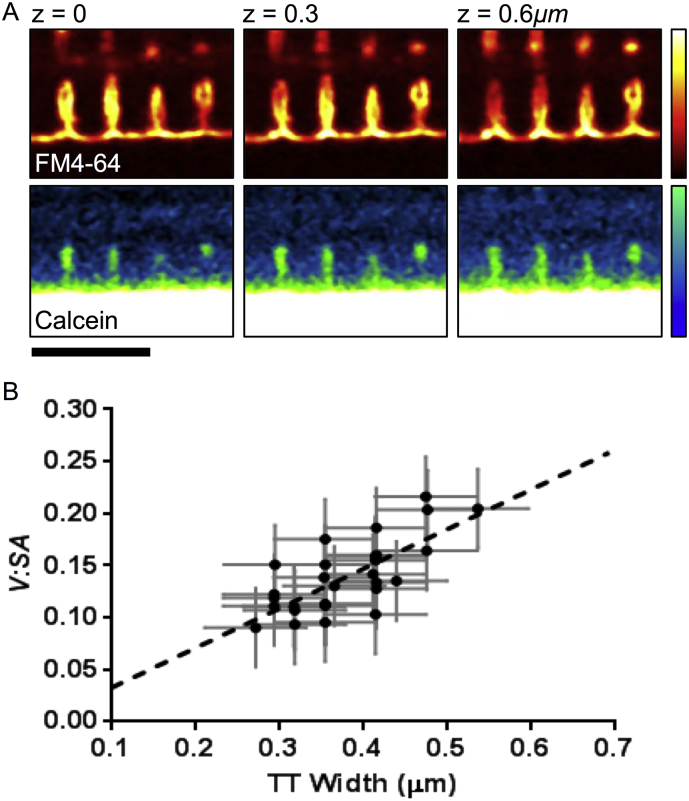
Estimation of TT diameter from the V:SA ratio. (A) Exemplar rabbit TTs with diameters above the optical resolution limit (i.e. showing a visible lumen). Position of the imaged plane along the optical axis, z, is indicated. The top panels show FM4-64 staining, highlighting the TT membranes invaginating from the SS z-grooves. Evidence showing that the space between the TT membranes is the lumen of a single TT is provided by the calcein dye signal. Scale bar 5 μm. (C) Tubule width measured manually, compared to the measured V:SA (filled circles, n = 30 tubules). The dashed line shows linear regression, which has a slope of 0.38 ± 0.07, which is not significantly different to that expected from a cylindrical model of TTs (0.39, see Supplementary Materials, Eq. 7).